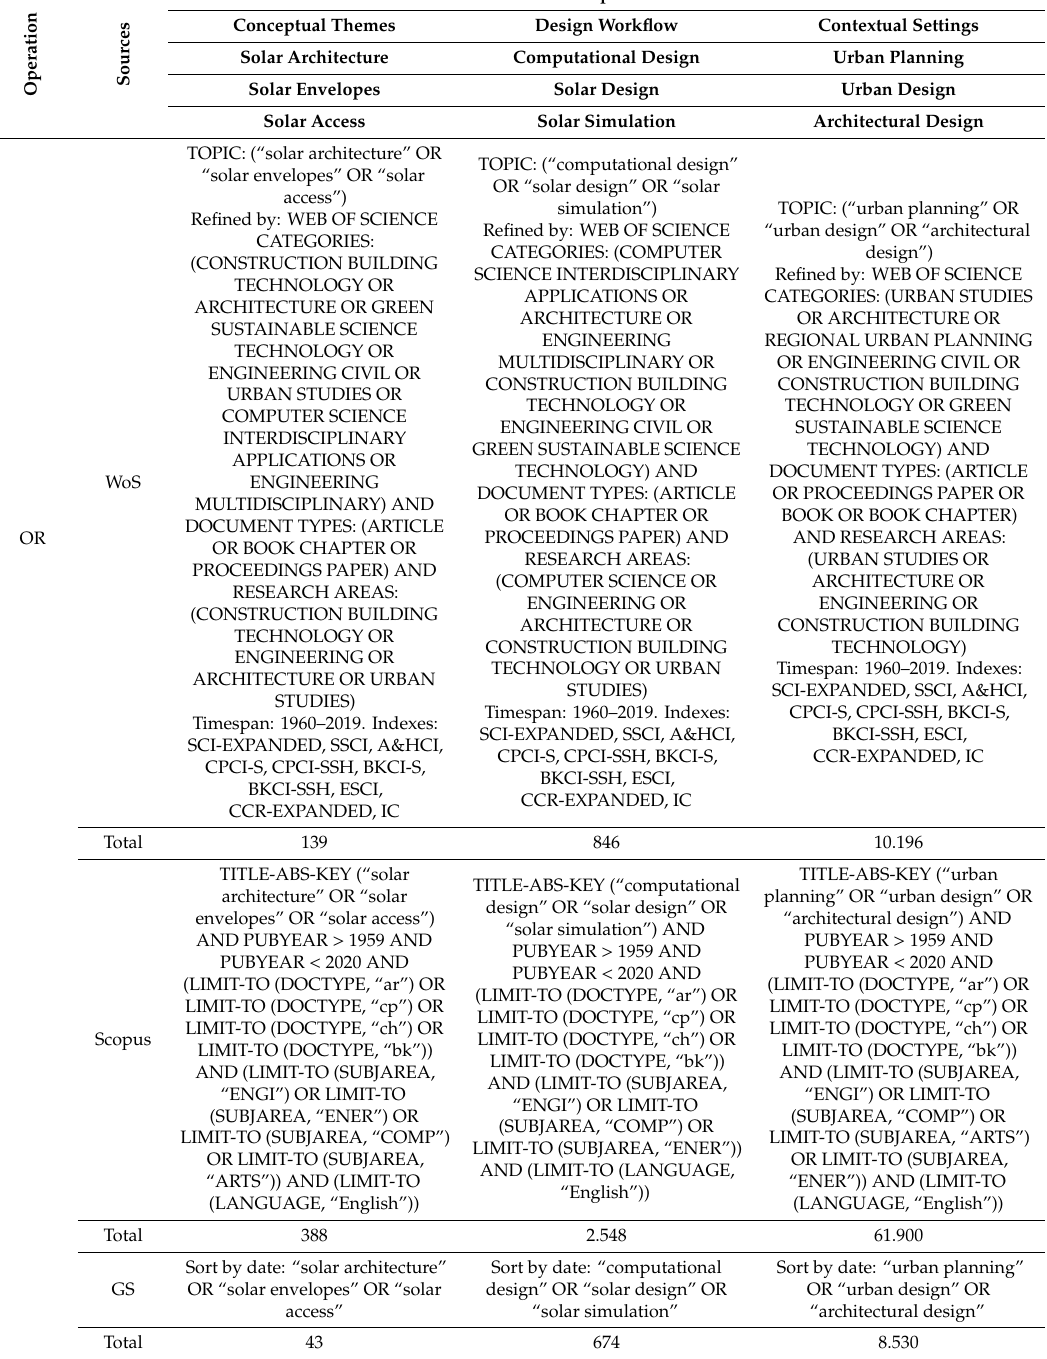
Table A1. Parameters selection for reference